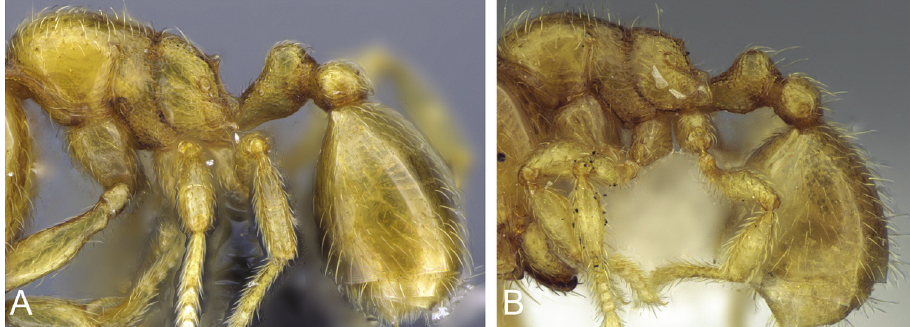
Figure 26. Mesosoma, petiole, postpetiole and gaster in profile view of A Carebara mahafaly (CASENT0151798) B Carebara salegi